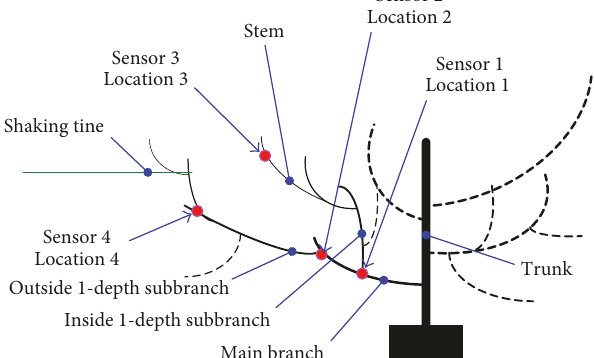
Table 2: The grouping method of experimental trees.